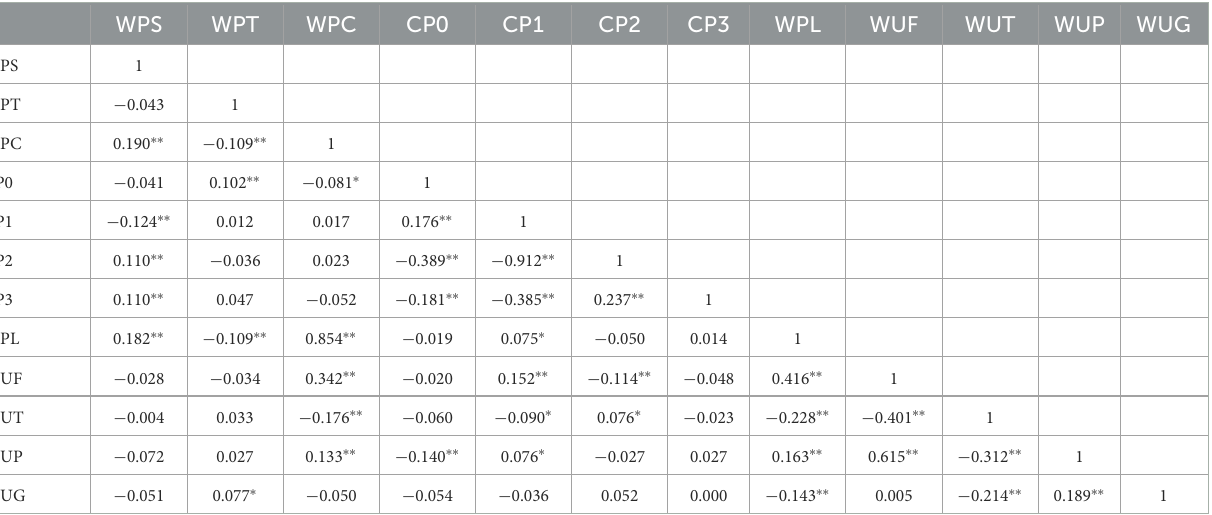
TABLE 7 Spearman correlation coefficient of the event “Fangfang